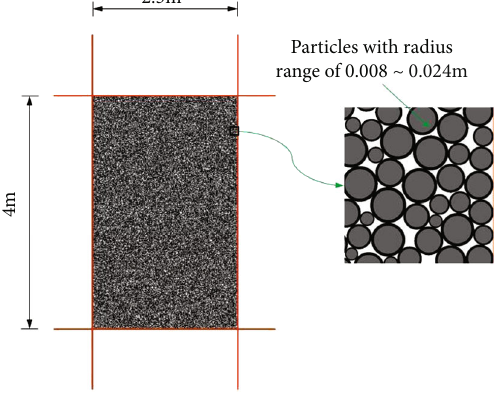
Figure 4: PFC model for biaxial test. Table 1: Micromaterial parameters of the PFC